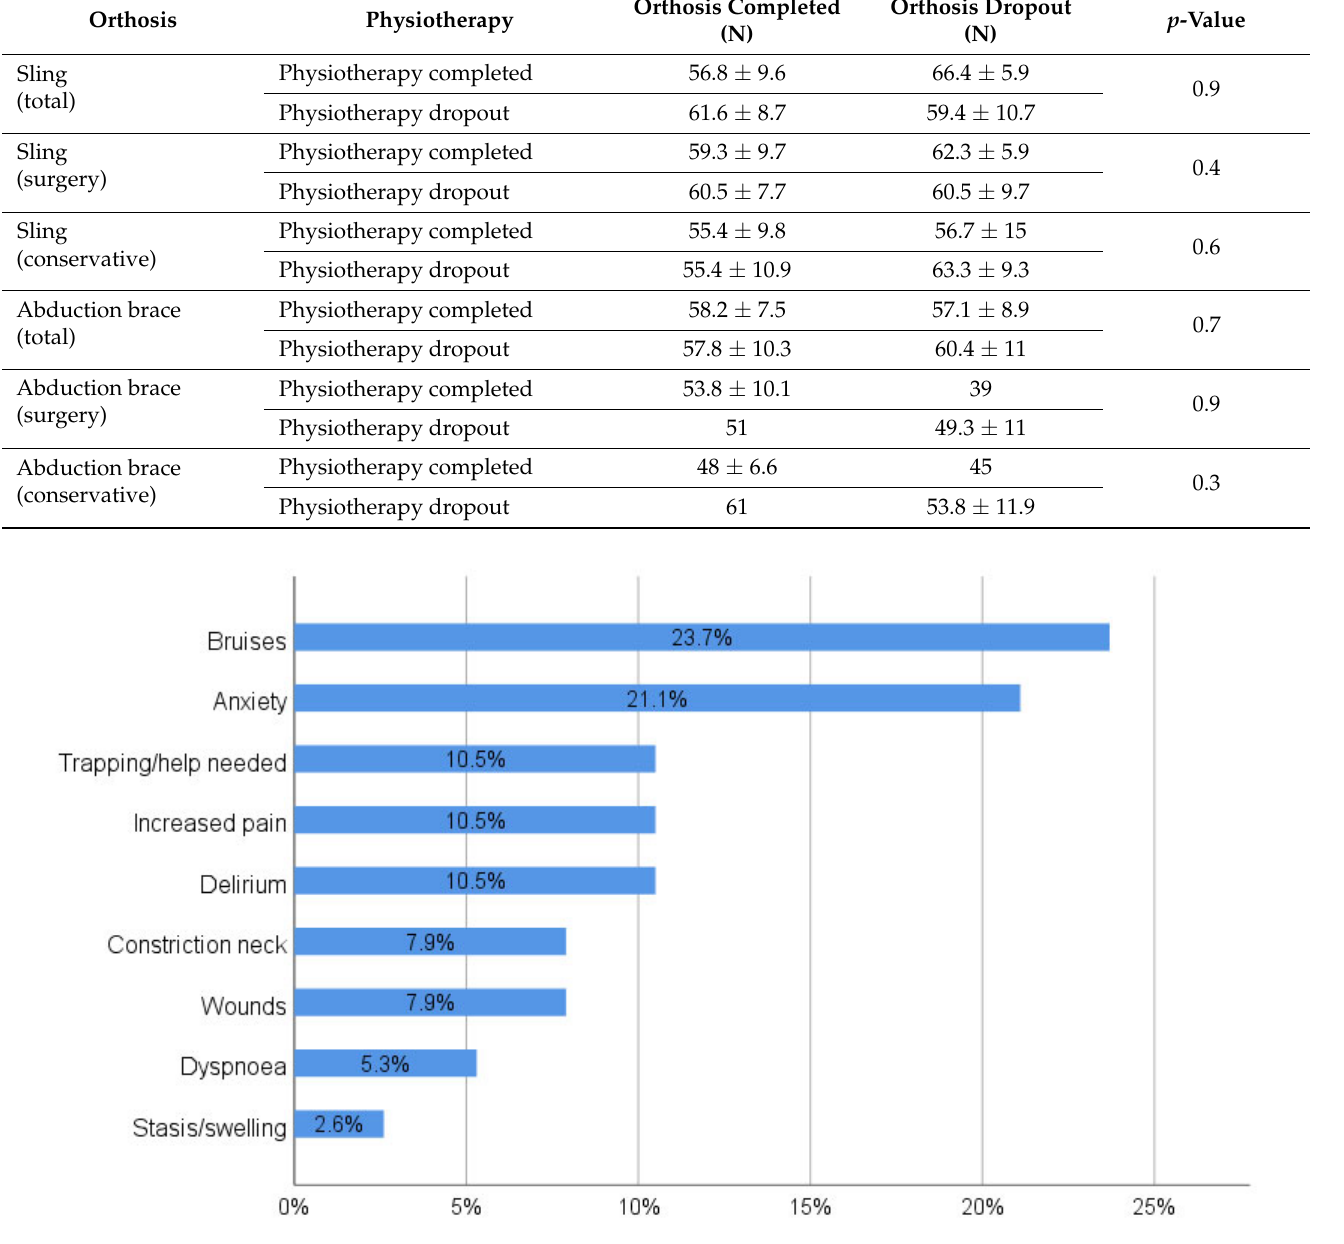
Figure 2. Reasons for early termination of orthosis therapy.